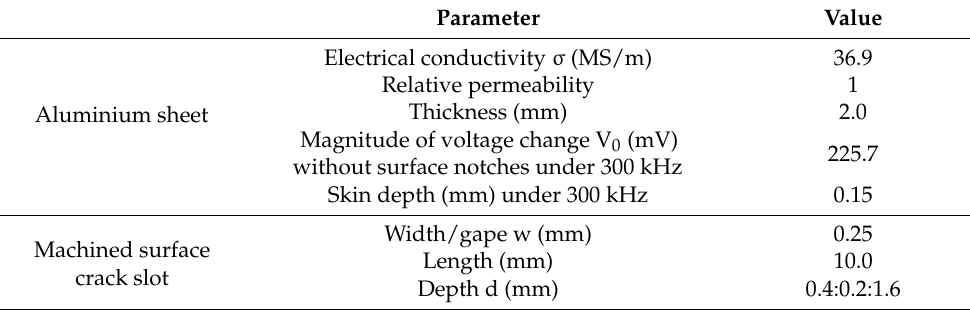
Table 2. Parameters of the conductive samples with long surface